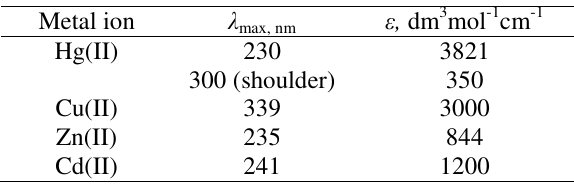
Table 2 . Acid dissociation constants of ligands at 25 °C and I=0.1 mol dm -3 KNO